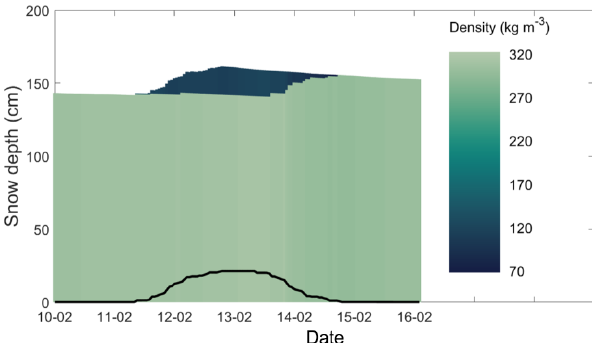
Figure 2. Evolution of snow density (colors) of the simplified snow- pack consisting of two layers, during one snowfall event. When HN 48 (black curve) was zero, both layers have the same density. For HN 48 > 0, the upper layer consists of lower-density snow (dark